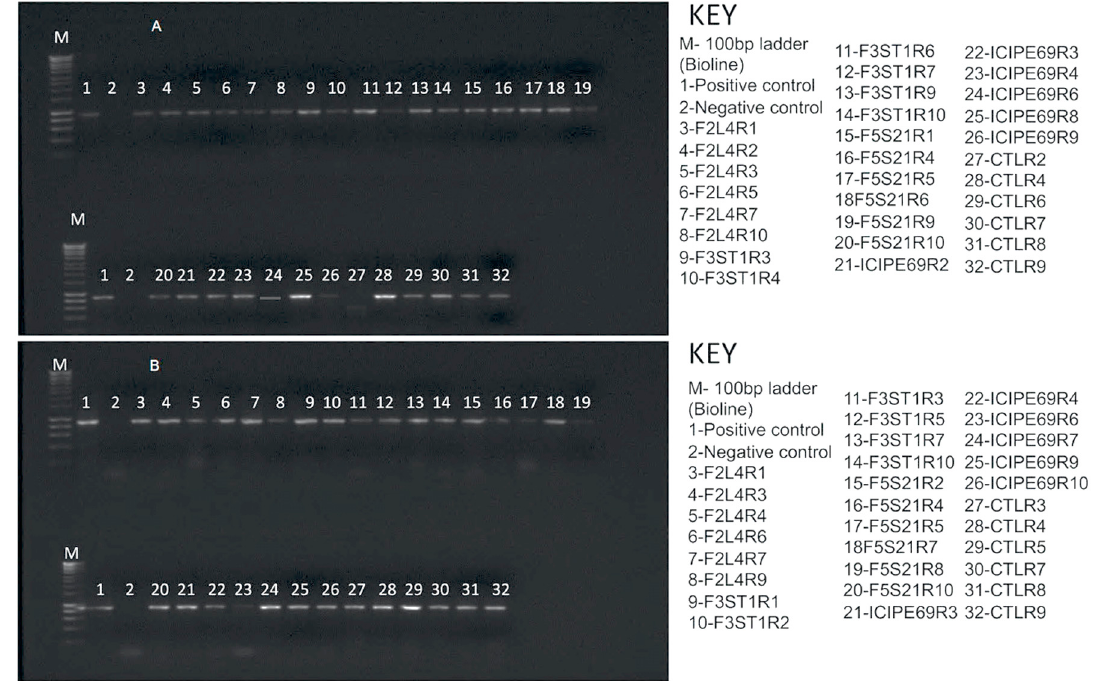
Figure 2. Reverse transcription-polymerase chain reaction (RT-PCR) detection of Sugarcane mosaic virus in leaf samples of di ff erent fungus-treated plants at 14 days post inoculation. Gels for trials one ( A ) and two ( B ) are presented. F2L4, F3ST1, F5S21 and ICIPE69 represent the fungal endophytes while R1–R10 represent the replicates that were randomly selected for evaluation.